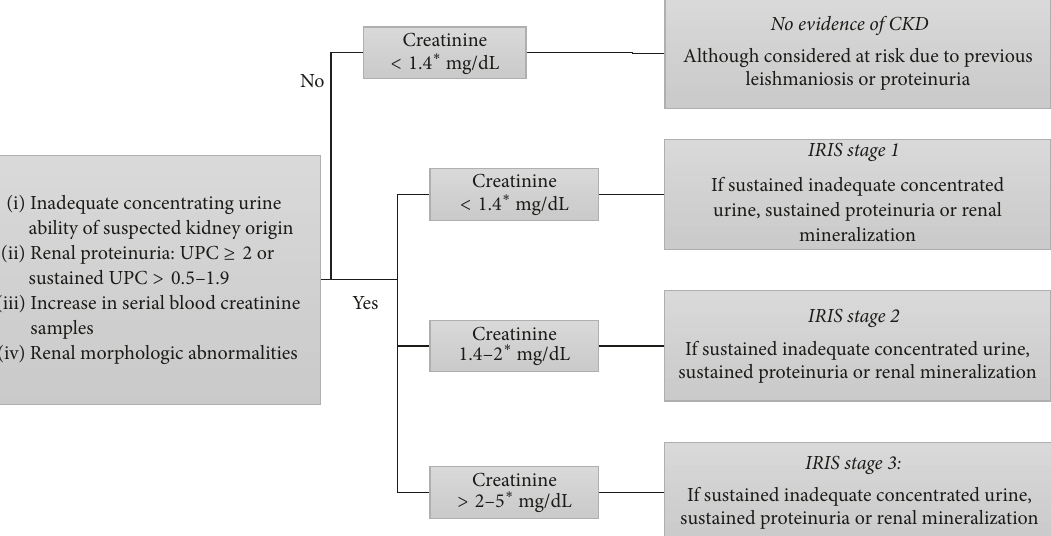
Figure 1: Algorithm for classifying dogs with leishmaniosis after six months of diagnosis according to the presence of CKD based on IRIS staging system [25]. IRIS: International Renal Interest Society; CKD: chronic kidney disease; UPC: urinary protein/creatinine ratio. ∗ Blood creatinine concentrations applied to average sized dogs. Values ≥ 1.4mg/dL were present more than once during the